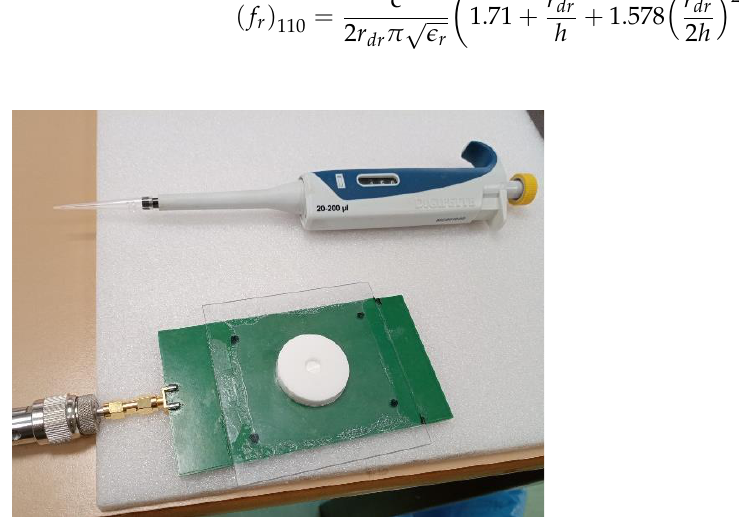
Figure 3. Experimental setup for the DR sensor with a polycarbonate supporting frame and the SMA connection to the VNA port.